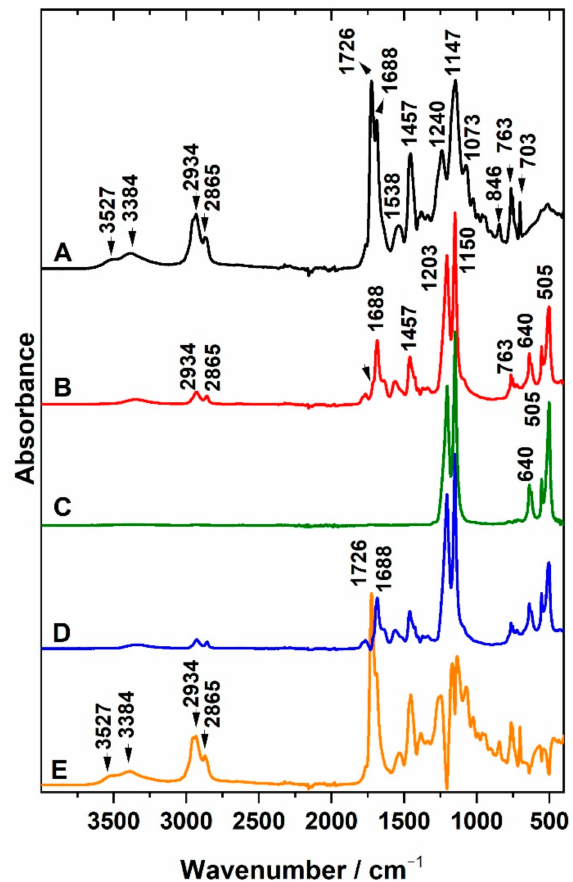
Figure 4. ATR spectra of non-modified polyurethane (PU) membrane ( A ), PU membrane from the contact side with PTFE ( B ), pure PTFE filter ( C ), and the spectral profile of components calculated by the MCR method ( D , E